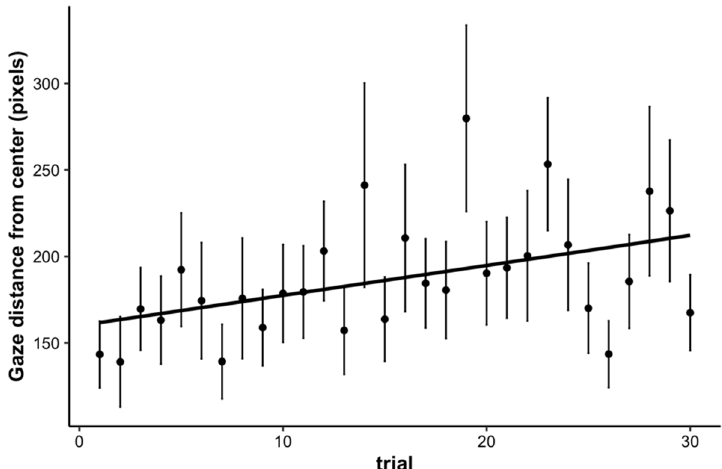
Figure 8. Average distance from the center of the screen of children’s fixations (in pixels) across trials. Children showed a significant increase in distance from center over the course of the task. Error bars represent +/ − one standard error.